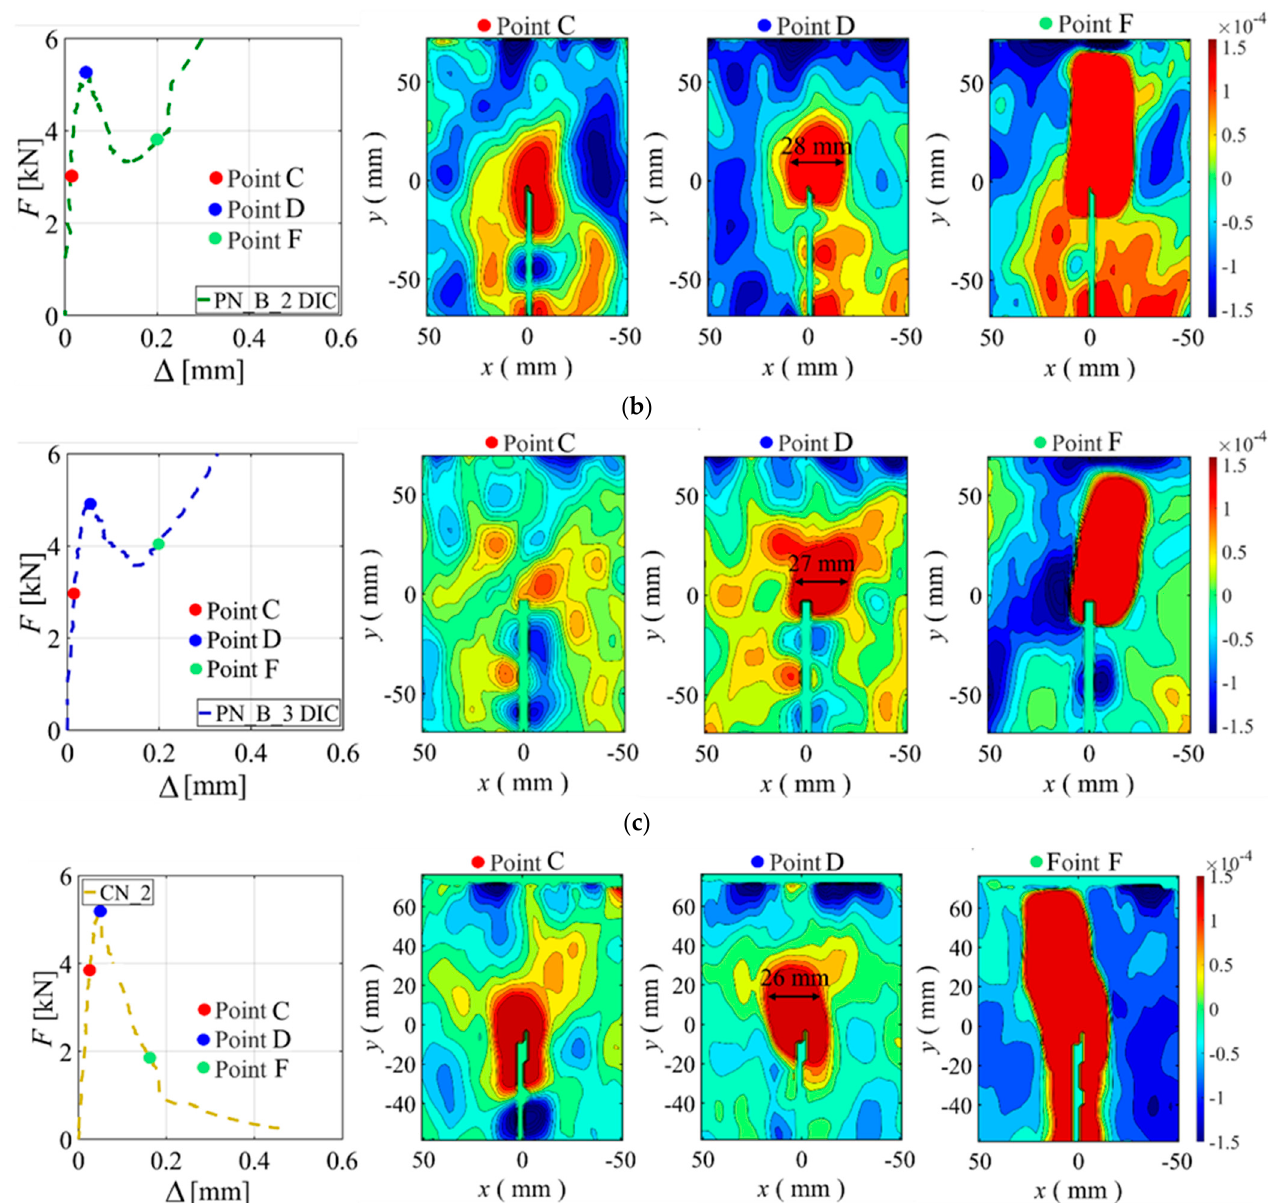
Figure 17. Contour plots of ε xx considering three different loading points: ( a ) PN_B_1; ( b ) PN_B_2; ( c ) PN_B_3; and ( d ) CN_2.